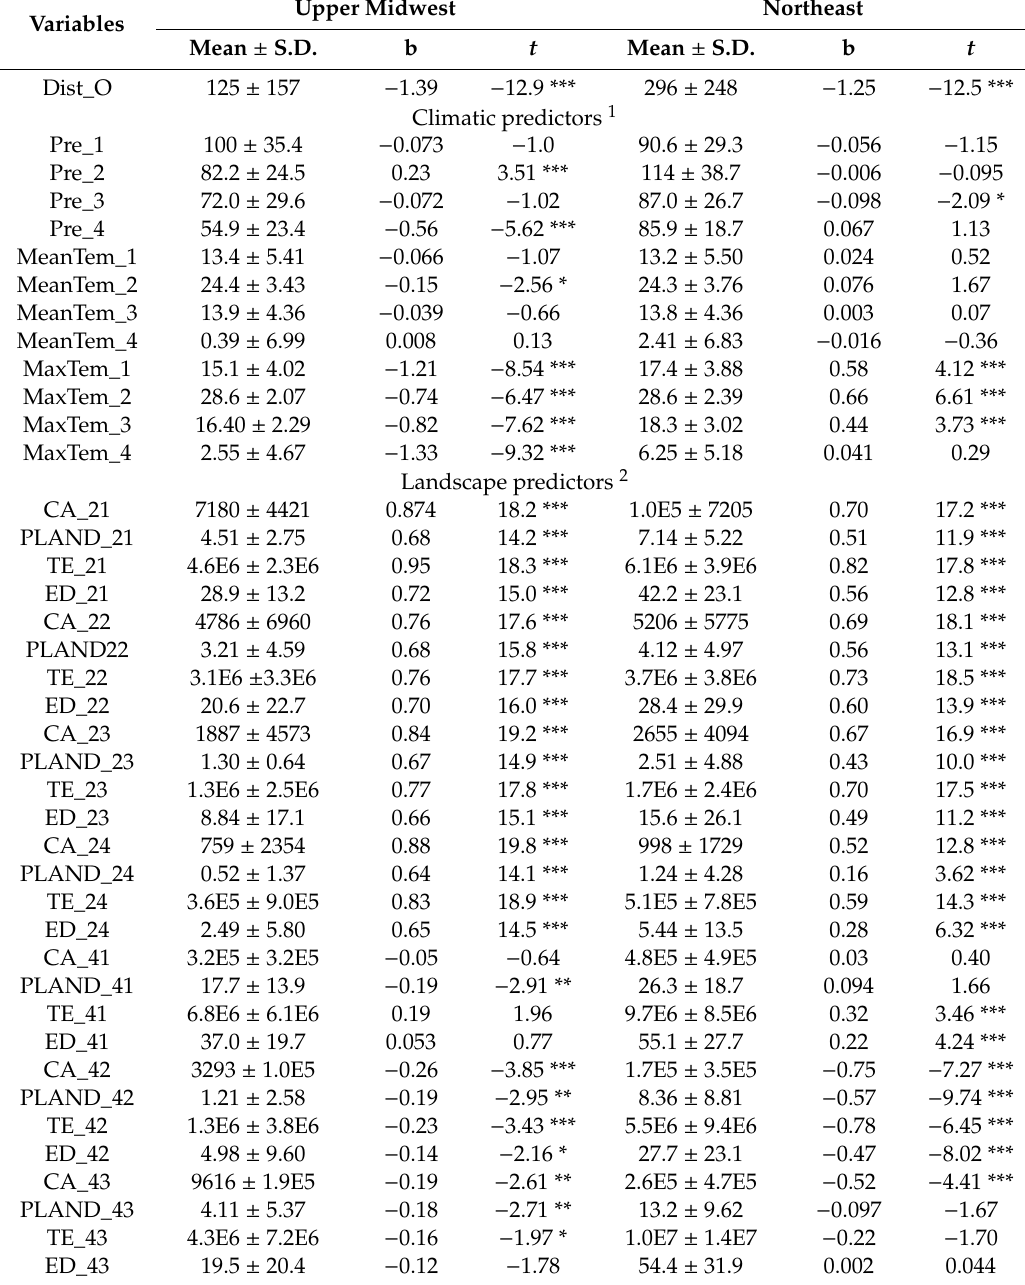
Table 2. Summary (Mean ± S.D.) and univariate regression results (standardized regression coe ffi cient, b, and t ) for the predictors correlated with the Lyme cases in the Northeast and Upper Midwest United